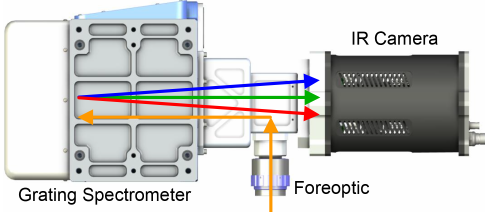
Figure 1. Light path inside each spectrometer.